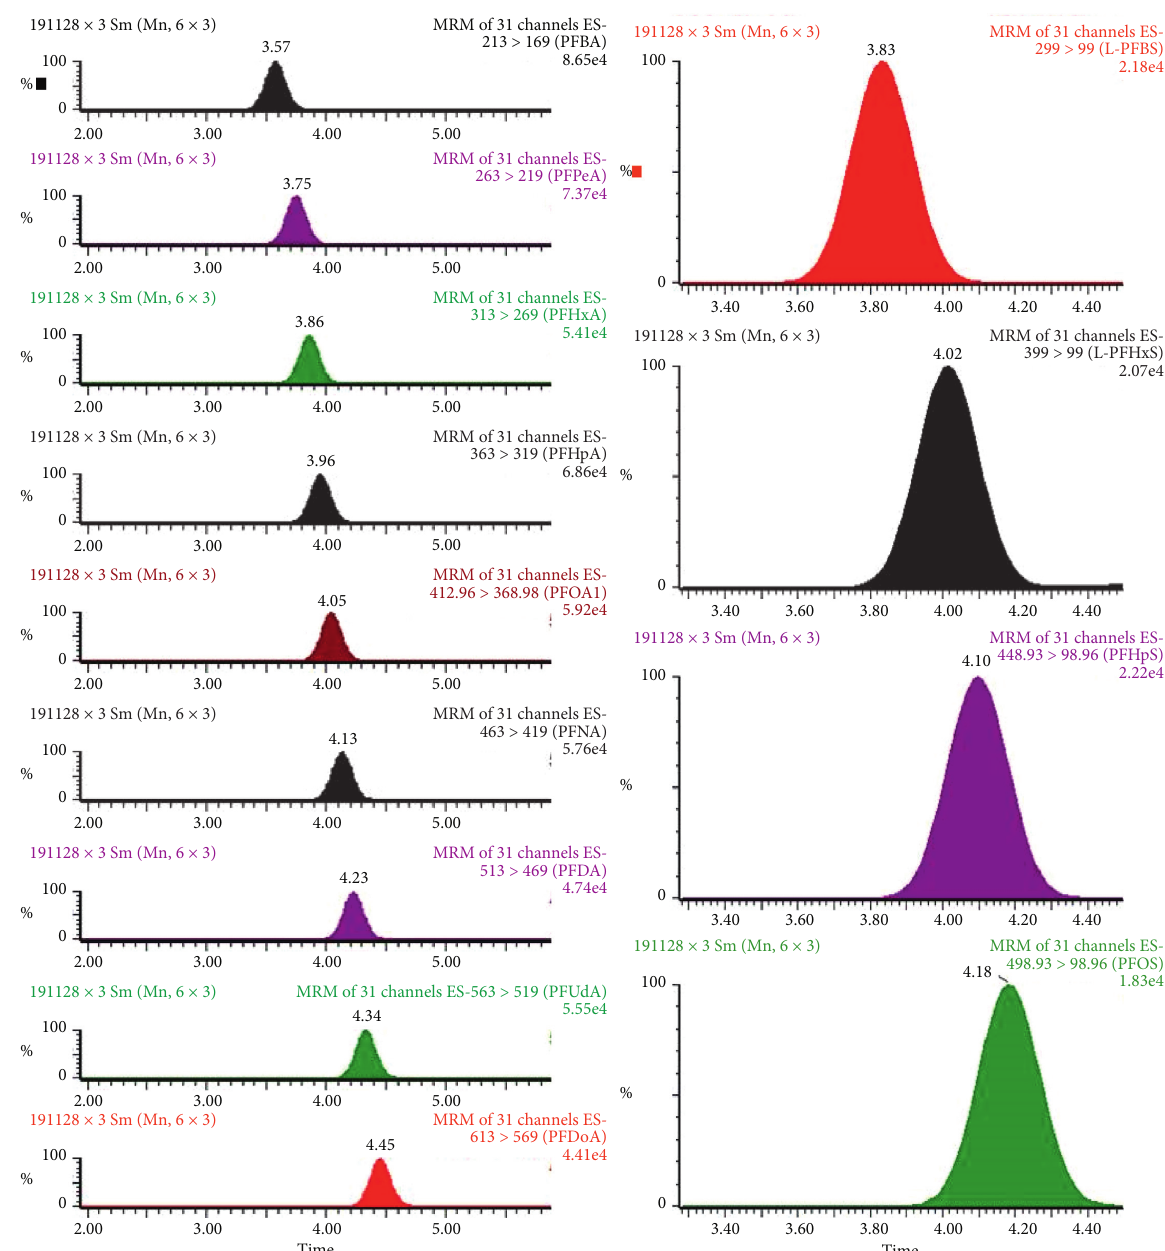
Figure 2: Chromatogram (MRM) of PFAS standard solution (perfluorocarboxylic acids (left) and perfluorosulfonate compounds